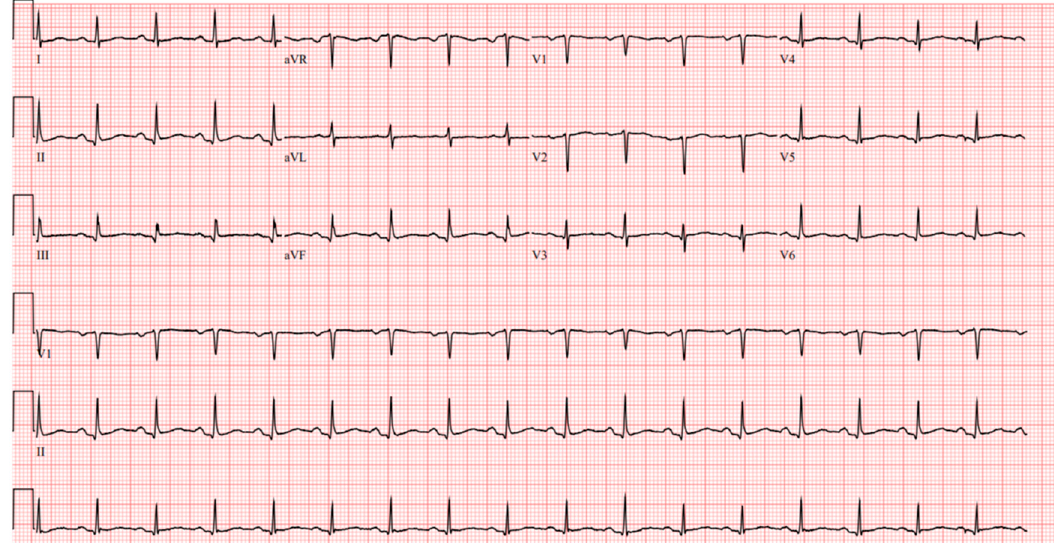
Figure 3. EKG showing sinus tachycardia with heart rate of 101